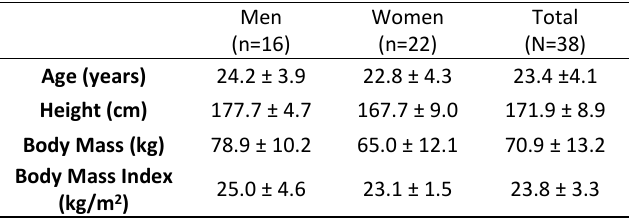
Table 1: Participant demographics (mean ±